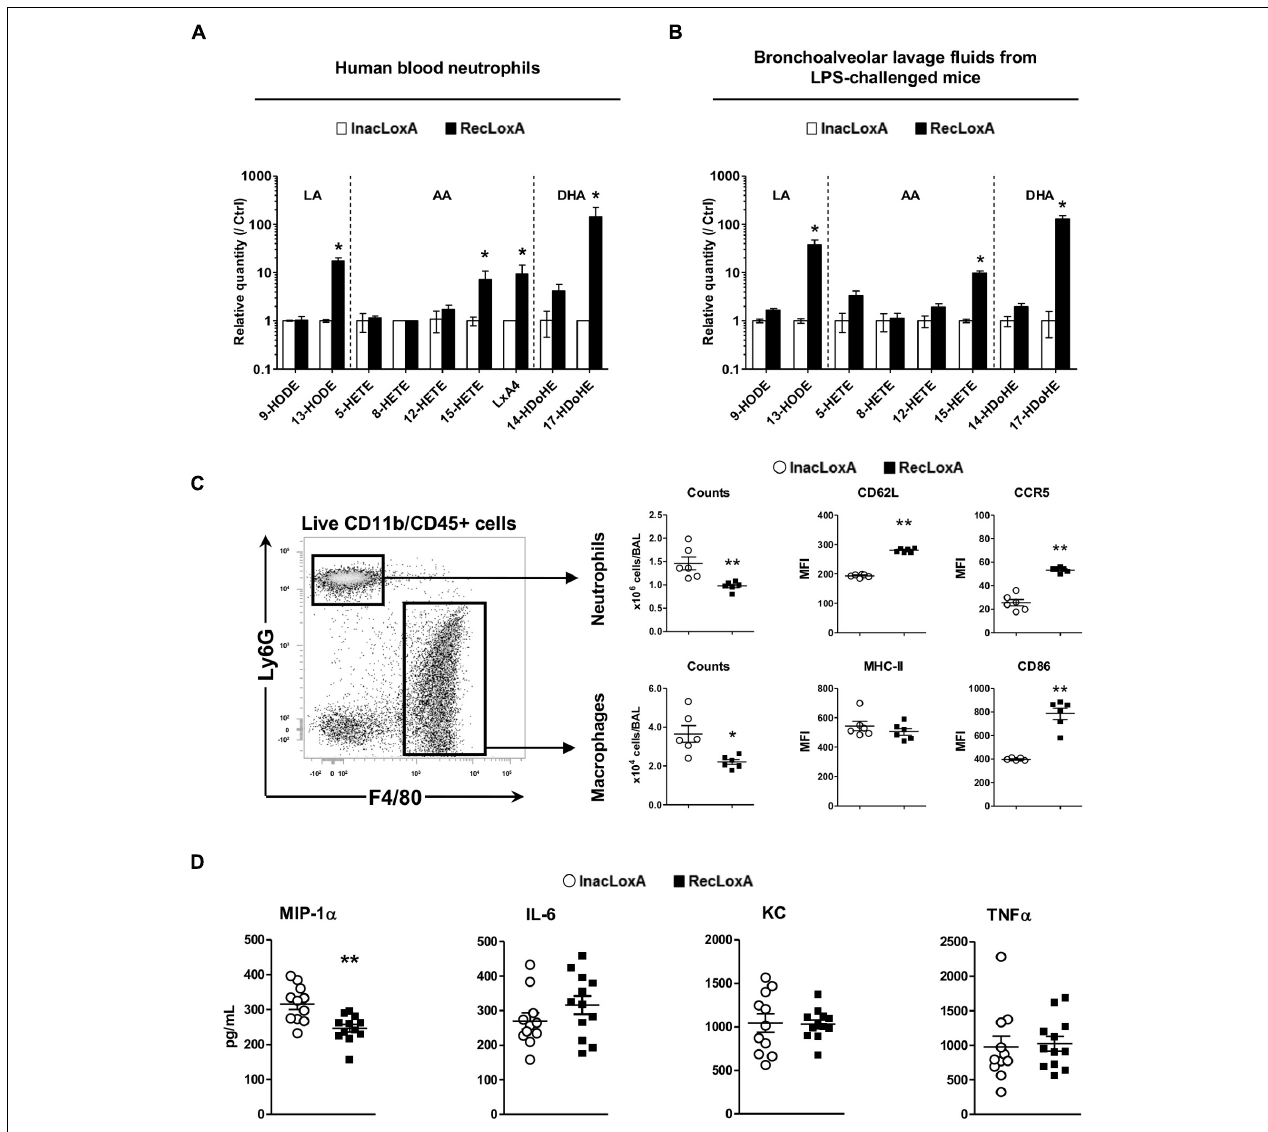
FIGURE 4 | LoxA activity impacts lung mucosal defense. (A) Blood neutrophils from 2 independent healthy donors were incubated with either active LoxA (RecLoxA; 0.5 µ g) or heat-inactived (InacLoxA; 0.5 µ g) as described in the experimental procedures. For each experiments, levels of lipoxygenase-derived eicosanoids were measured by LC-MS/MS. Data are expressed as mean ± SEM of fold-induction over values measured in neutrophils incubated with InacLoxA ( n = 3). Data are representative of two independent experiments, ∗ p < 0.05 when compared to inactive InacLoxA. See Supplementary Table S3 for absolute quantification values. (B) Balb/c mice were intranasally instilled with LPS (3 µ g/mice) alone or with either active recombinant LoxA (RecLoxA, 5 µ g/mice) or heat-inactivated recombinant LoxA (InacLoxA; 5 µ g/mice; as negative control). Levels of lipoxygenase-derived eicosanoids in BALF were measured by LC-MS/MS after 24 h. For each experiment, both cell and supernatant fractions were analyzed and pooled for representation. Data are expressed as mean ± SEM of fold-induction over values measured in mice challenged by LPS and InacLoxA. See Supplementary Table S4 for absolute quantification values. Data are representative of three independent experiments, ∗ p < 0.05 vs. LPS-InacLoxA. (C) Gating strategy used in flow-cytometry analysis. Cell recruitment and cell-surface expression of CD62L and CCR5 on neutrophils or cell-surface expression of CD86 and MHC-II on macrophages were analyzed by flow cytometry in BALF. Data are the mean ± SEM ( n = 6 mice/group) and are representative of three distinct experiments. ∗ p < 0.05; ∗∗ p < 0.01 vs. LPS/InacLoxA. (D) Concentrations of IL-6, KC and MIP-1 α in BALF were determined by ELISA and are represented as the mean ± SEM ( n = 12 mice/group). ∗ p <